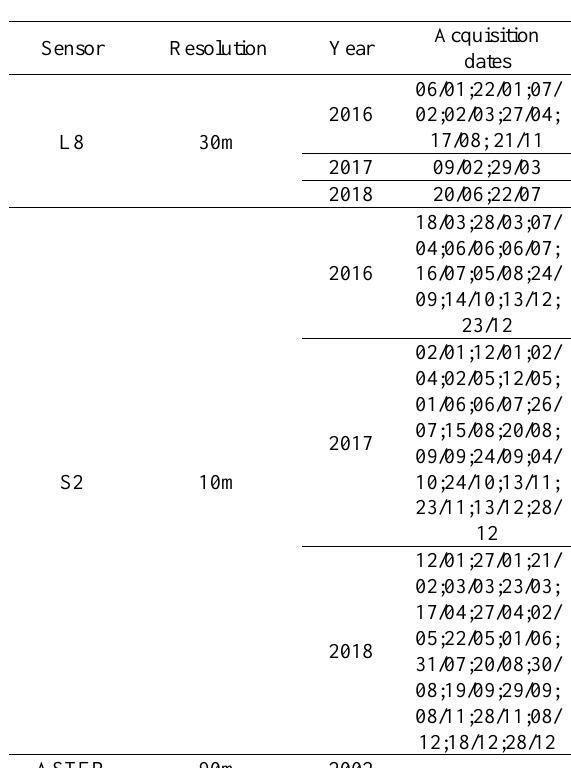
Table 2. Size and source of the used ground truth references, for the different classes training and testing over the last three